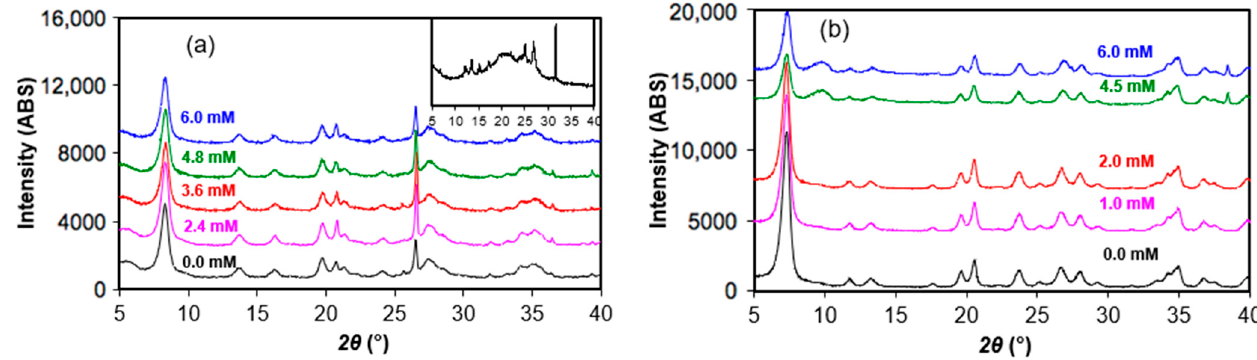
Figure 5. XRD patterns of PAL ( a ) and SEP ( b ) after TB sorption from different initial concentrations. The inset in is the XRD pattern of solid TB.